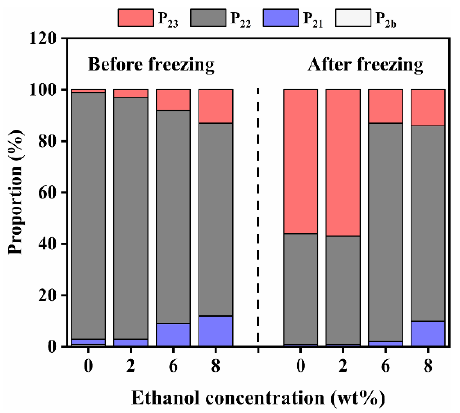
Figure 5. The proportion of water distribution of konjac emulgel-based fat analogue (KGFA) with different ethanol before and after freeze-thaw treatment. P 2b , P 21 , P 22 and P 23 were the corresponding area fractions of T 2b , T 21 , T 22 and T 23 in Figure 4.